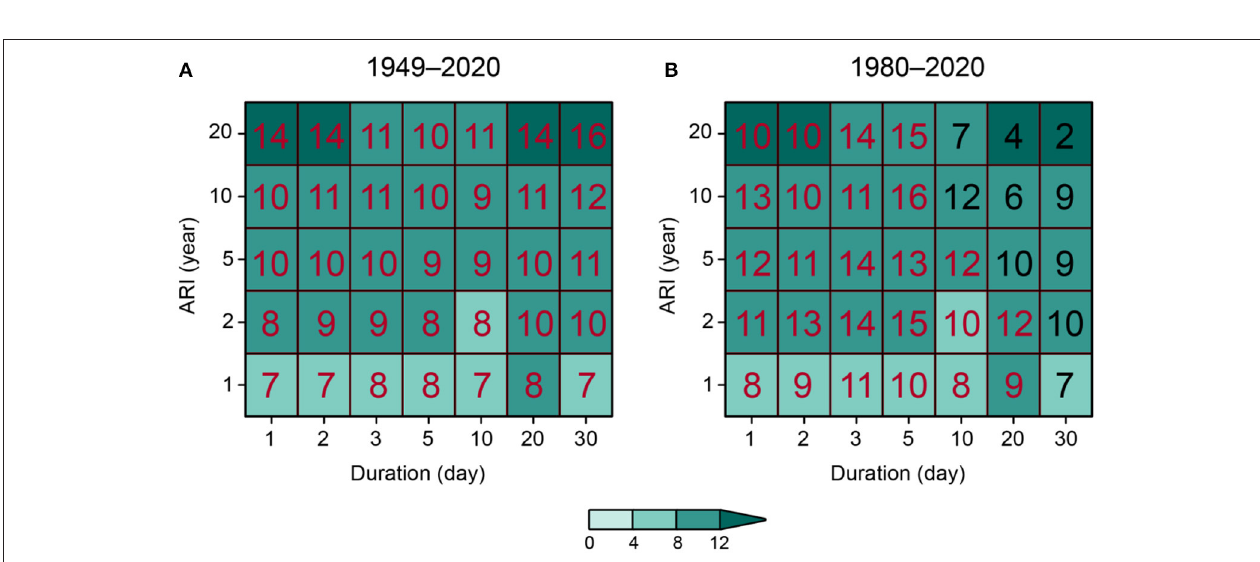
FIGURE 7 | Annual time series (1908–2020) of two metrics of the precipitation amounts for those events exceeding the station-specific thresholds for daily 5-yr ARI events: the average precipitation for the extreme events (“Average Annual Event Precipitation”; teal color) and the single largest precipitation value among the extreme events (“Max of Annual Event Precipitation”; orange color). These time series are based on data from the 57 long-term stations. The trend values and p -values of the trend lines are displayed in the legend.